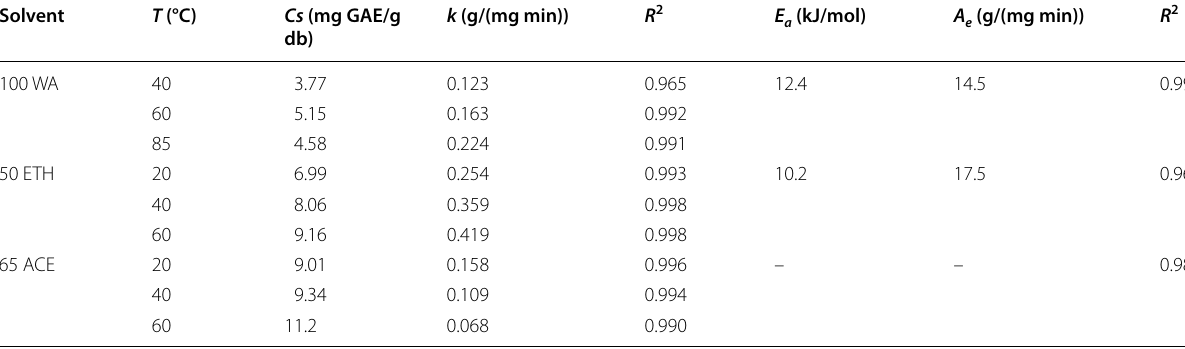
Table 5 Kinetic parameters obtained from second-order model